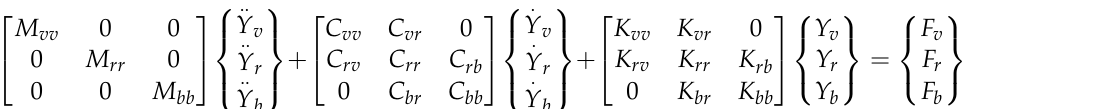
Figure 3. A sample of acceleration signals for front (1st) and rear (2nd) bogies for different damage levels at mid-span at the speed of 105 kph. To provide a stronger damage-sensitive feature with more discriminating power, Continuous Wavelet Transform (CWT) with Morse Wavelet was used. The Fourier trans- form of the generalised Morse Wavelet can be represented by Equation (3) [51]: Ψ 𝑃,𝛾 ( 𝜔 ) = 𝑈(𝜔)𝑎 𝑃,𝛾 𝜔 𝑃 2 𝛾 𝑒 −𝜔𝛾